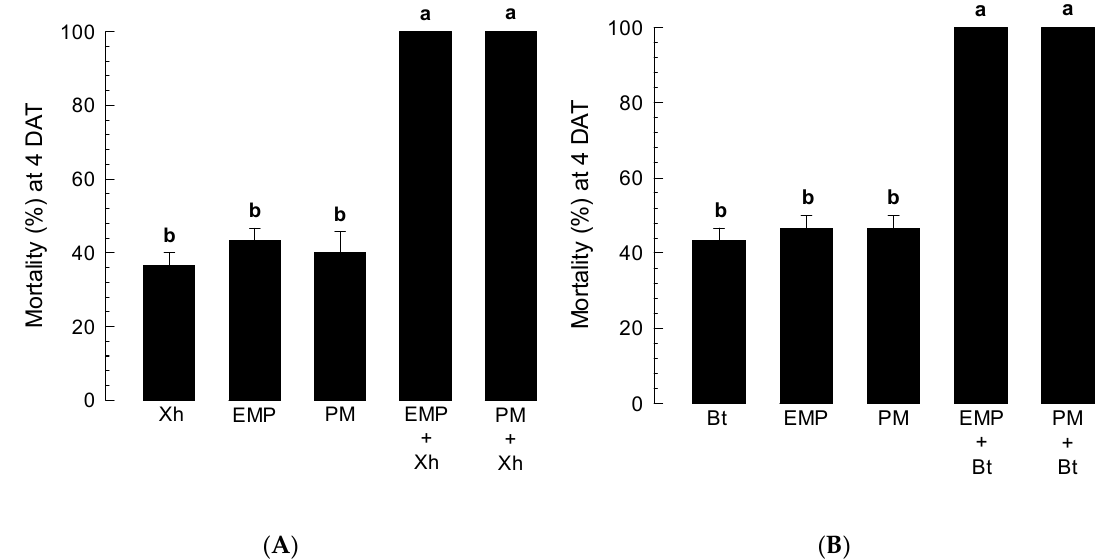
Figure 7. Enhanced insecticidal activities of bacterial pathogens by two potent PLA 2 inhibitors: 3-ethoxy-4-methoxyphenol (EMP) and phthalimide (PM). ( A ) Enhanced effect of the inhibitors on X. hominickii (Xh) pathogenicity. L5 larvae of S. exigua were hemocoelically injected with low dose (10 2 cfu/larva) of Xh or along with the PLA 2 inhibitors (5 µg/larva). ( B ) Enhanced effect of the inhibitors on Bacillus thuringiensis (Bt) pathogenicity. A small piece (2 cm 2 ) of cabbage leaf was dipped in Bt (500 ppm) or a mixture with PLA 2 inhibitor (500 ppm). The treated leaves were provided to test S. exigua larvae. Each treatment was replicated three times with 10 insects per replication. Different letters above standard deviation bars represent significant differences among means at Type I error = 0.05 (LSD test). Insecticidal activity was assessed at four days after treatment (DAT).